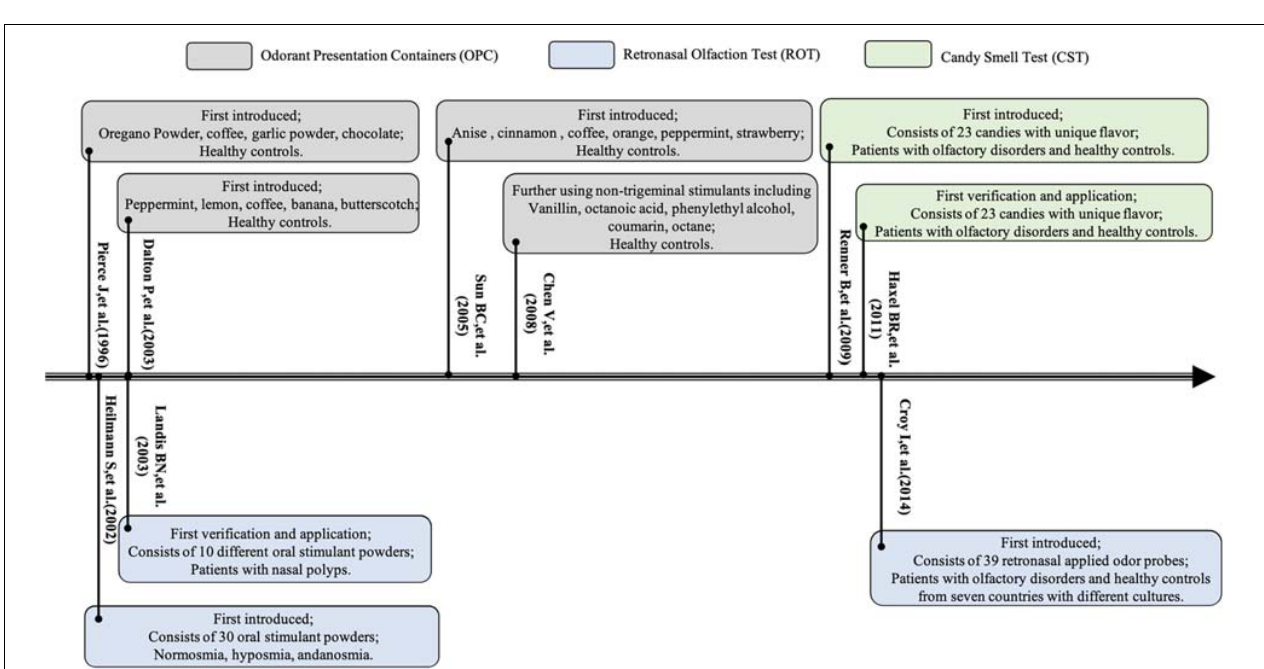
FIGURE 1 | Timeline for development of the orthonasal olfaction tests between 1963 and 2012. OT, olfactory threshold; OD, olfactory differentiation; OI, olfactory identification.